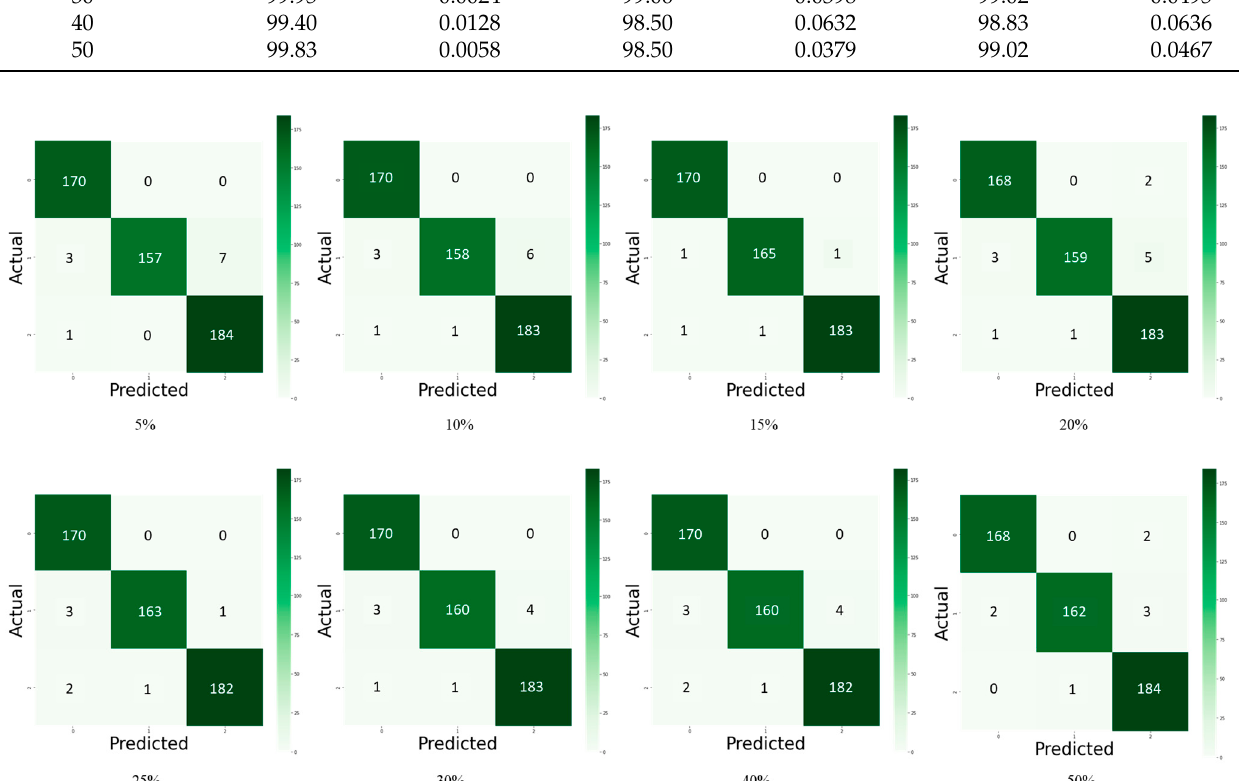
Figure 5. Confusion matrix of tomato leaf disease detection for Inception V3 model with 5%, 10%, 15%, 20%, 25%, 30%, 40%, and 50% dropout values, numbers represent the classes used for testing where : 0 = Early Blight, 1 = Yellow Leaf Curl Virus, and 2 = Healthy.